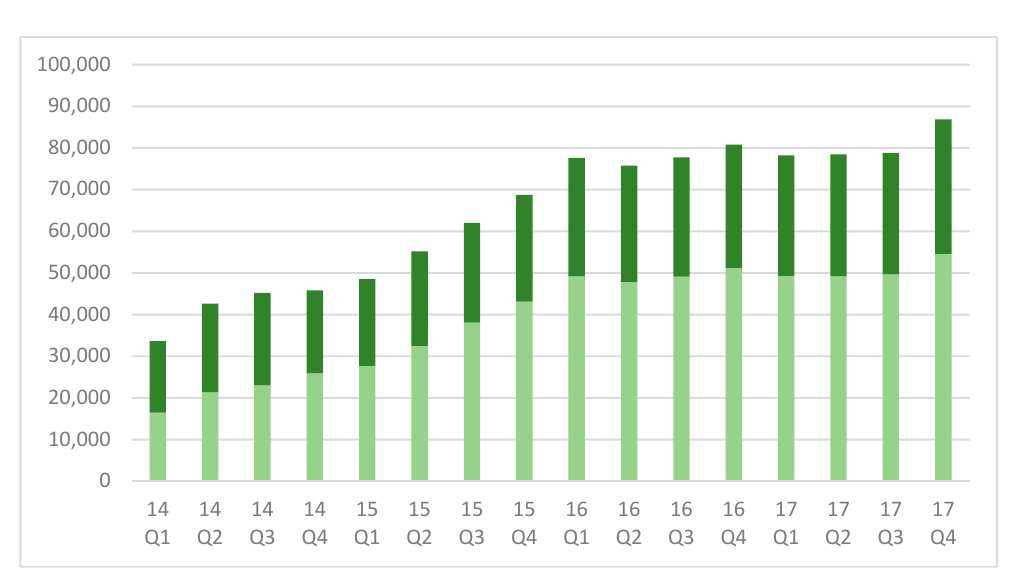
Figure 1. Cases reported by quarter, 2014–2017. Light green = women < 35; Dark green = women ≥ 35.